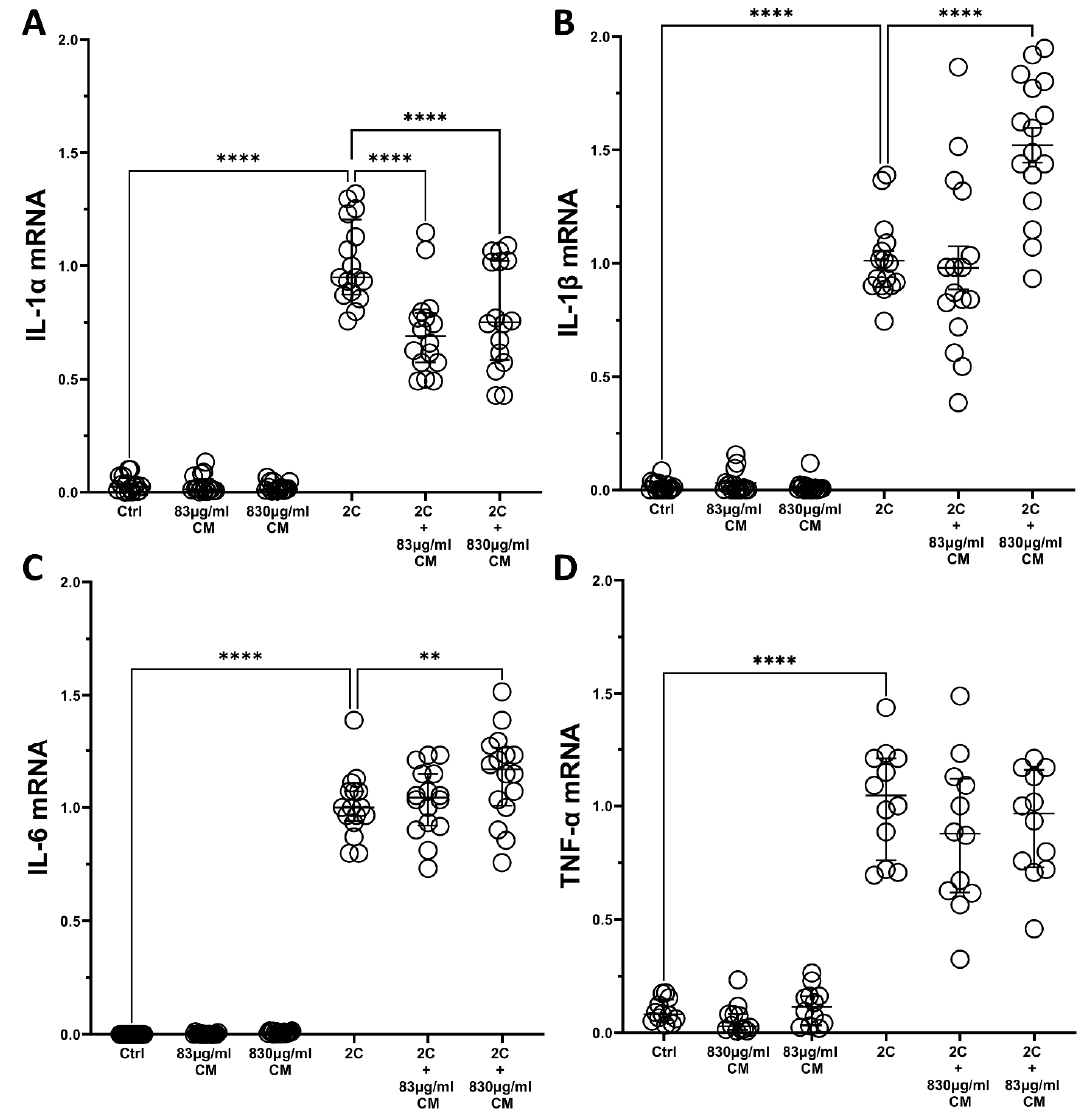
Figure 6. The effect of CM on interleukin mRNA expression in hPSMs, which are under pro- inflammatory stimuli. Both CM doses downregulate the mRNA expression of IL-1 α ( A ), the higher CM dose upregulates the mRNA expression of IL-1 β ( B ) and IL-6 ( C ), and no effect on the